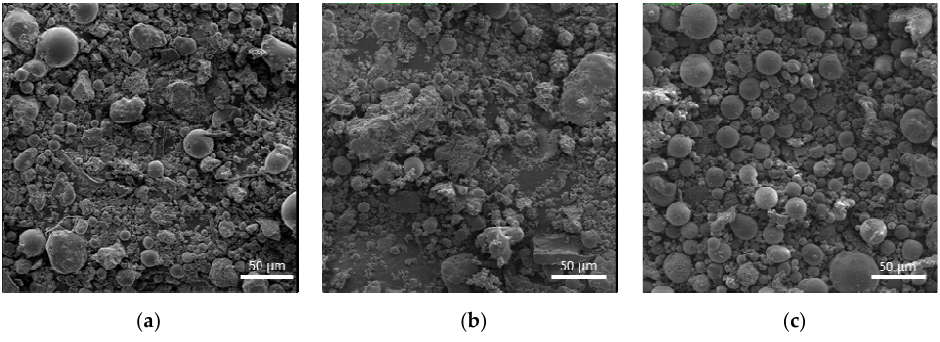
Figure 2. Micrographs of the fly ash products. ( a ) FA1; ( b ) FA2; ( c ) FA3.